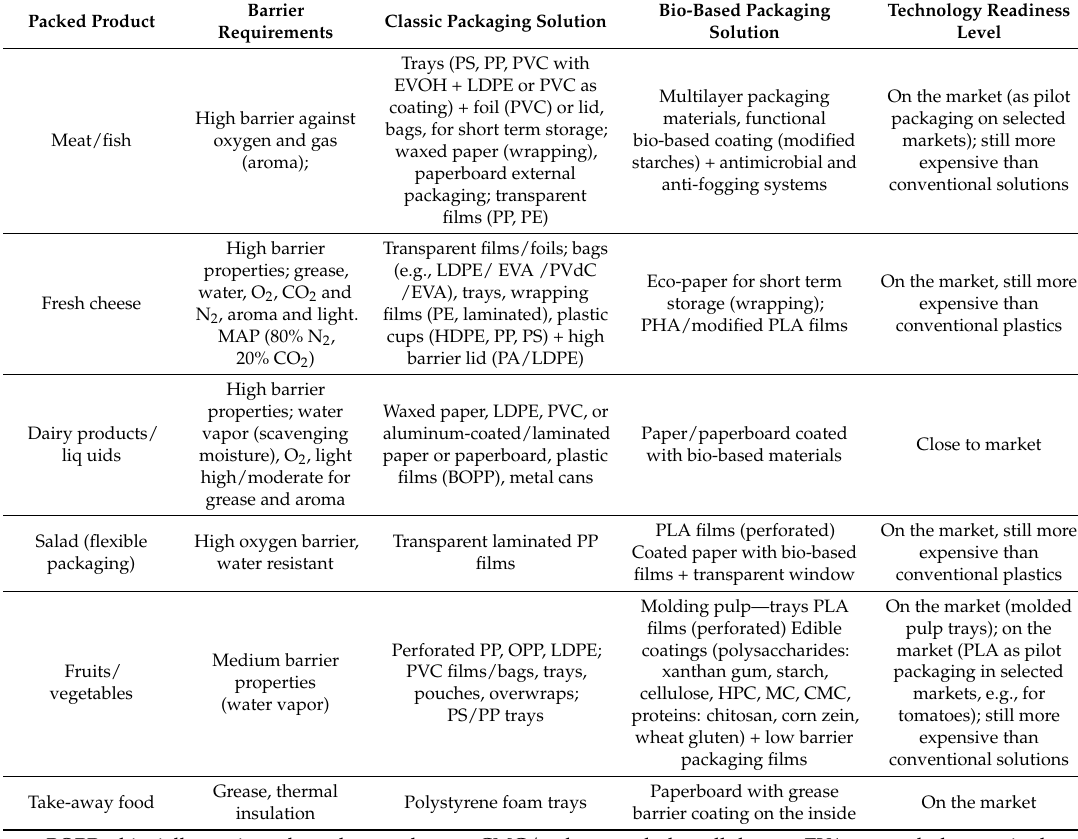
Table 4. Barrier properties of selected foodstuffs with classic and bio-based packaging systems [293]. Packed